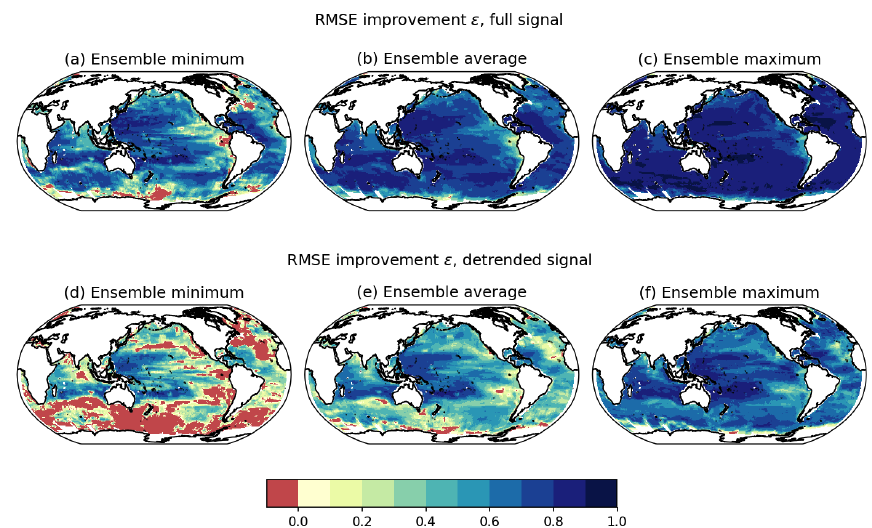
Figure 6. As for Fig. 5 but with RMSE improvements over the upper 100m for the scheme that uses Argo 2015-type temperature and salinity observations within 5 ◦ of the reconstruction